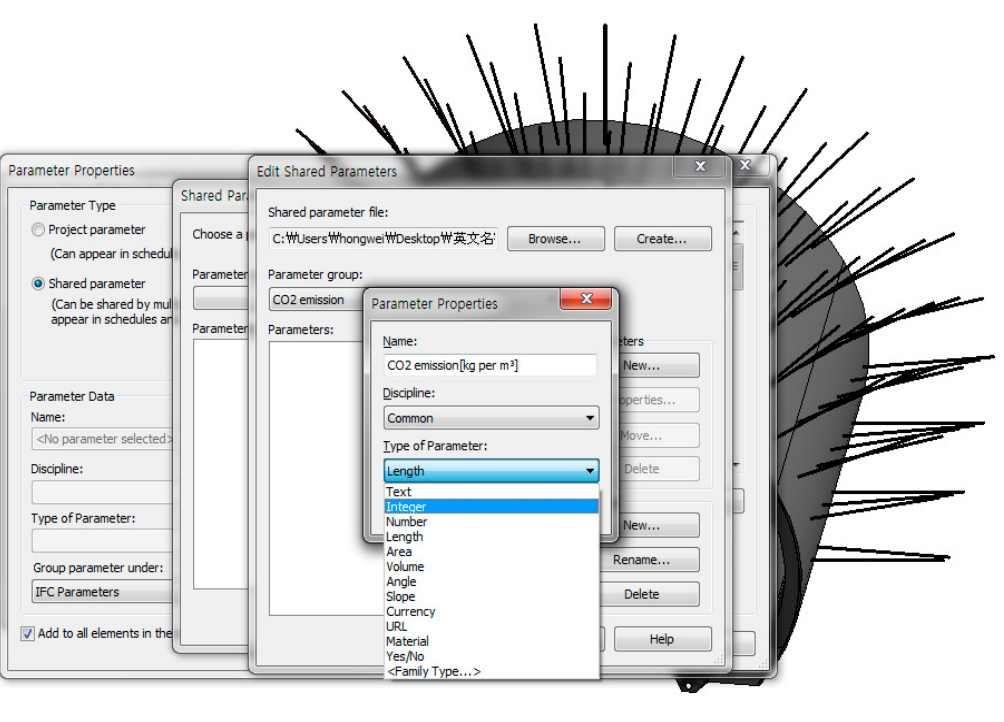
Table 3. Main construction equipment research scope.